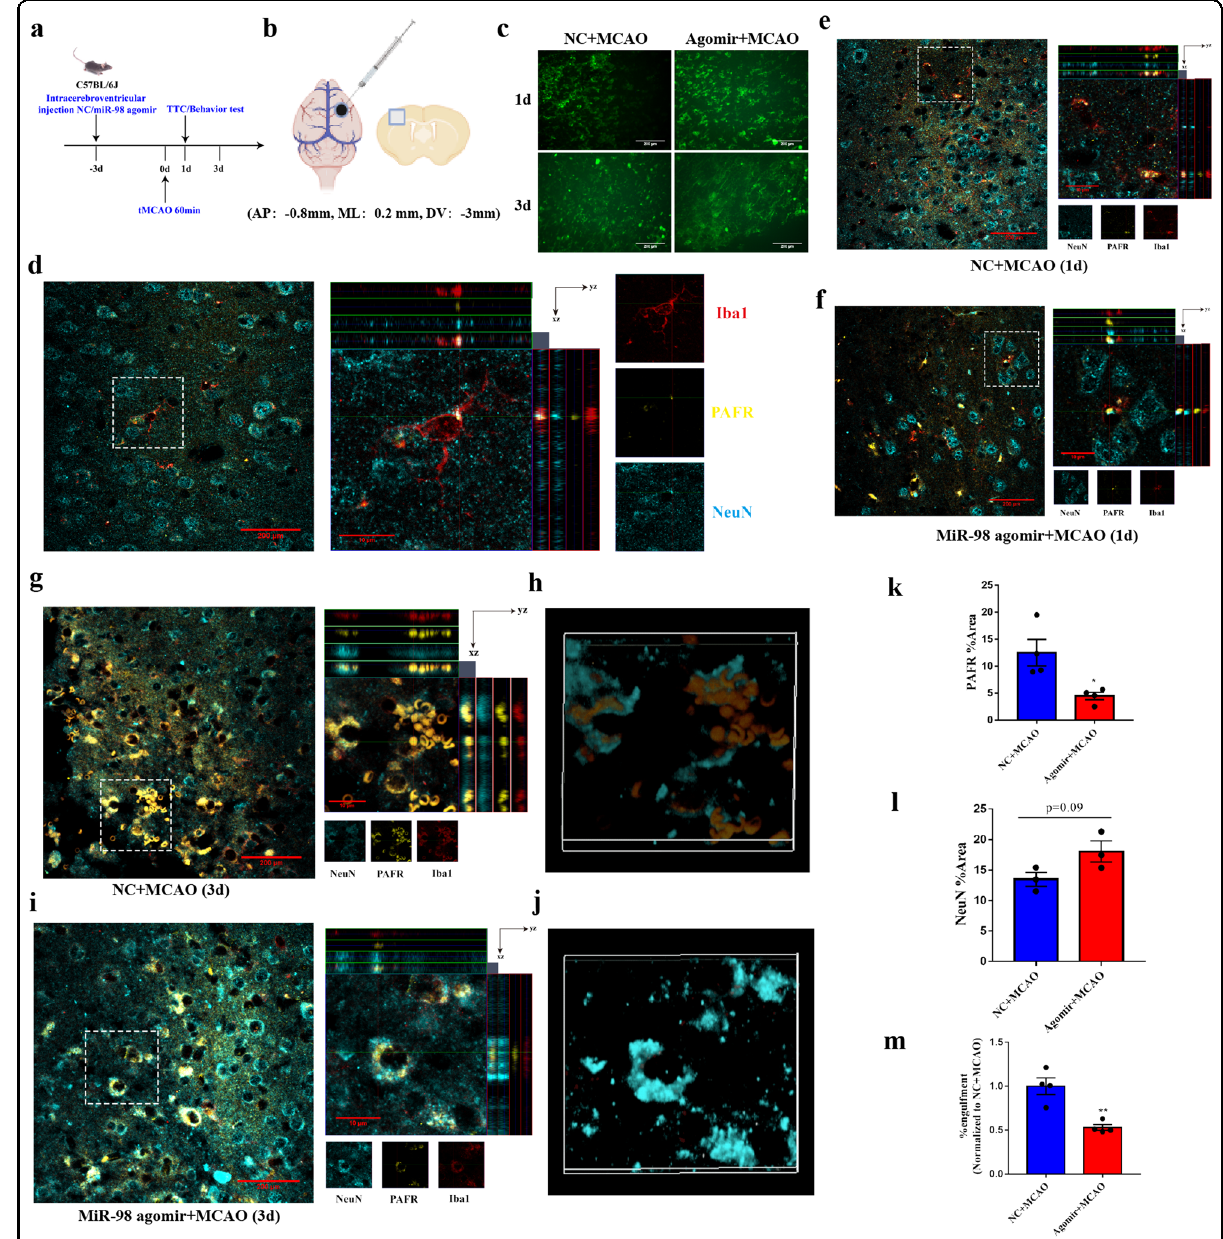
Fig. 5 MiR-98 can inhibit the microglial phagocytosis of “ stress but viable ” neurons after ischemic stroke through downregulating PAFR. a – b The procedure and localization of intracerebroventricular injection of miR-98 agomir (negative control) in mice. c The representative of miR-98 expression in the ipsilateral regions 1 day and 3 days after ischemic stroke with miR-98 agomir treatment in FISH. (Scale Bar = 200 μ m). d The representative immunostainings and Z-stack images of NeuN, IBA1, and PAFR colocalization in mice brain slices of sham group. e – f The representative immunostainings and Z-stack images of NeuN, IBA1, and PAFR colocalization in mice brain slices of mice with NC/miR-98 agomir treatment 1 day after ischemic stroke. g – j The representative immunostainings and Z-stack images, 3D reconstructions of NeuN, IBA1, and PAFR colocalization in mice brain slices of mice with NC/miR-98 agomir treatment 3 days after ischemic stroke. These Z-stack images and 3D reconstructions of original pictures were required by a Confocal Microscopy or two-photon Microscope. ( n = 3 independent experiments). k – m Quanti fi cation of the fl uorescent %area of PAFR and NeuN and microglial engulfment 3 days after ischemic stroke with NC/miR-98 agomir treatment. Data are shown as means±S.E.M., * P <0.05 vs corresponding control. the lesions. Strikingly, Z-stack images and 3D recon- ipsilateral lesions (Fig. 5e, f). On the third day after structions showed that miR-98 agomir treatment sig- ischemic stroke, microglia abundantly shifted into pha- ni fi cantly inhibited microglial phagocytosis of dying gocytes and vigorously ate stressed but viable neurons in